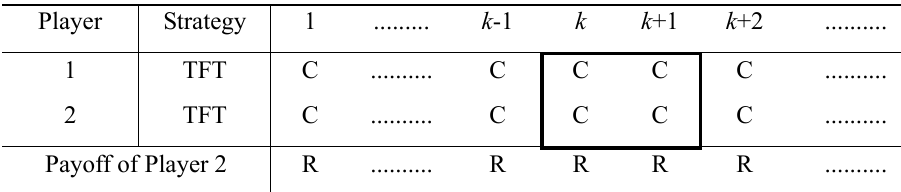
Table 2. TFT versus TFT